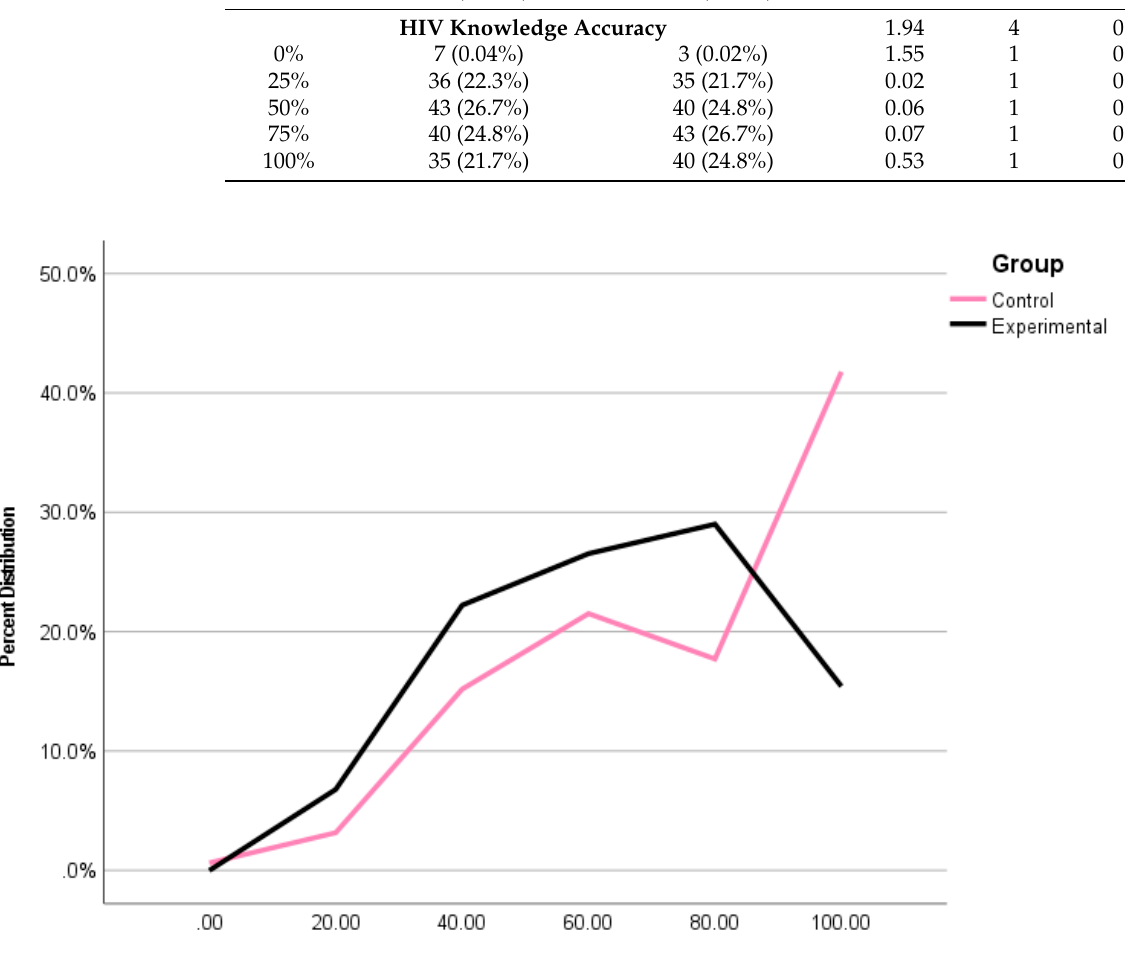
Figure 2. Percentage distribution of accuracy of oral HIV self-testing knowledge (in percentages) between experimental ( n = 161) and control groups ( n = 161).